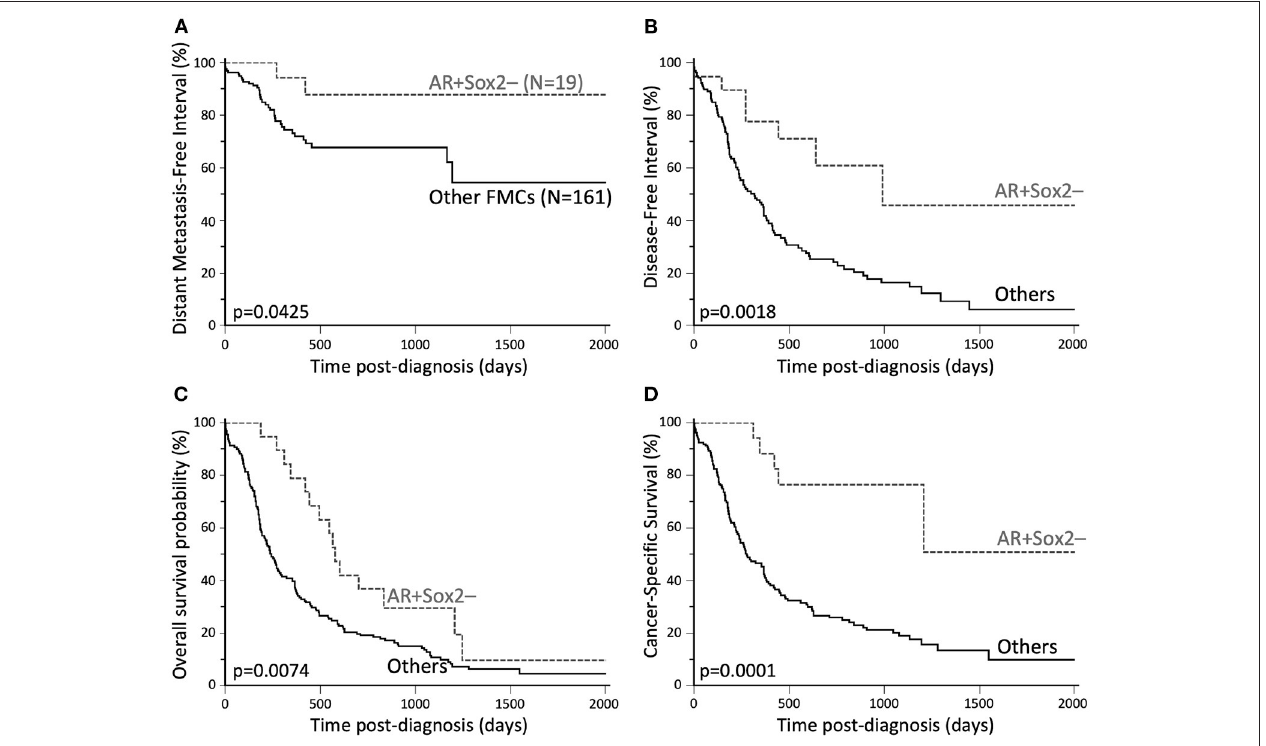
FIGURE 3 | Favorable outcomes associated with AR + Sox2–FMCs. (A) Distant Metastasis-Free Interval. The probabilities of distant metastasis at 2 years post-diagnosis were 12% in the AR + Sox2– group, and 32% for other FMCs. (B) Disease-free interval. The median DFI was 32.5 months in the AR + Sox2– group, and 10.4 months for other FMCs. The probabilities of cancer progression at 2 years post diagnosis were 29% and 75% for AR + Sox2– and other FMCs, respectively. (C) Overall survival. The median OS times were 19.0 and 8.0 months in the AR + Sox2– and other-FMC groups, respectively. (D) Cancer-specific survival. At 2 years post-diagnosis, 23% of the cats in the AR + Sox2– group, and 74% of the cats with other FMCs had died from cancer. Kaplan-Meier